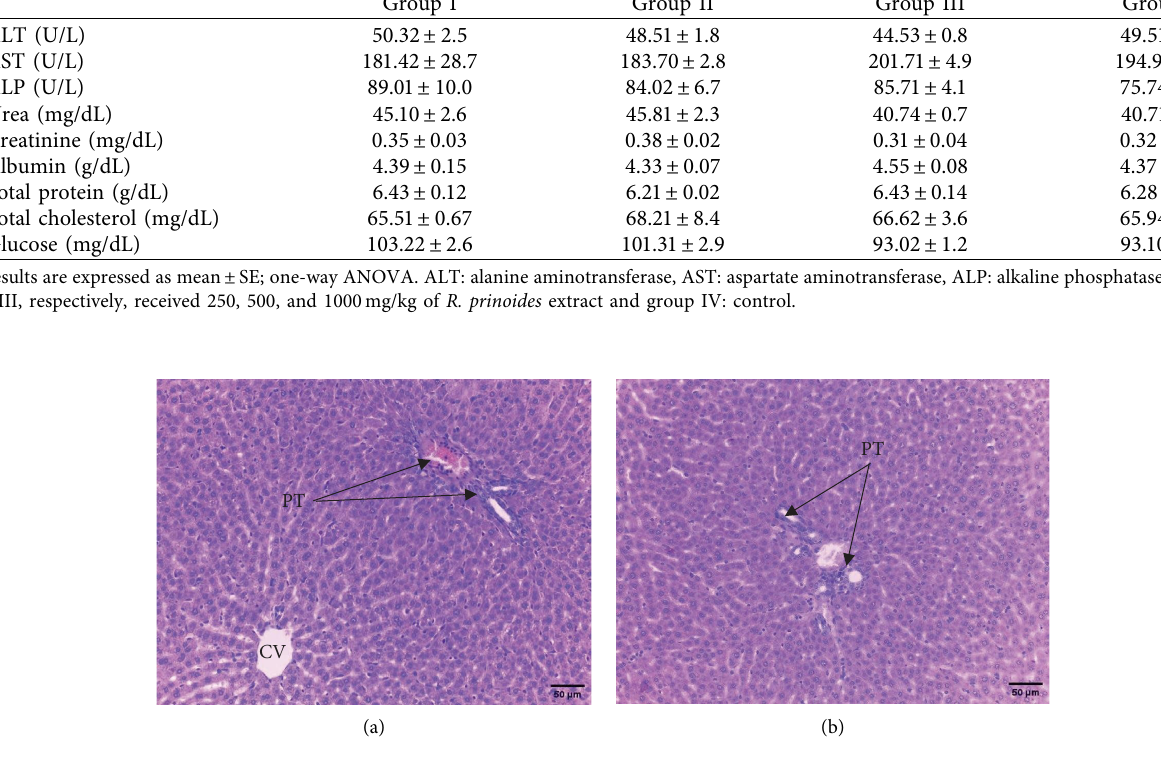
Figure 2: Photomicrograph showing normal rat liver, section (a) taken from rats in group III (1000mg/kg), section (b) taken from rats in group IV (control); PT: portal triad, CV: central vein; H and E stain, and 200x magnifcation.